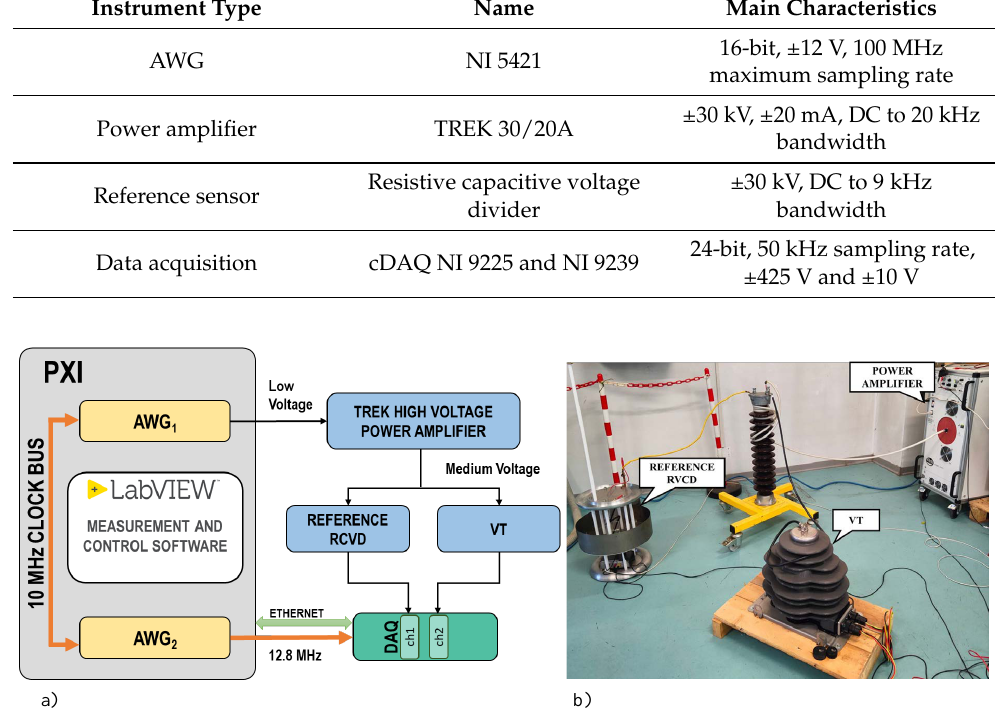
Figure 1. Functional diagram ( a ) and laboratory picture ( b ) of the generation and measurement